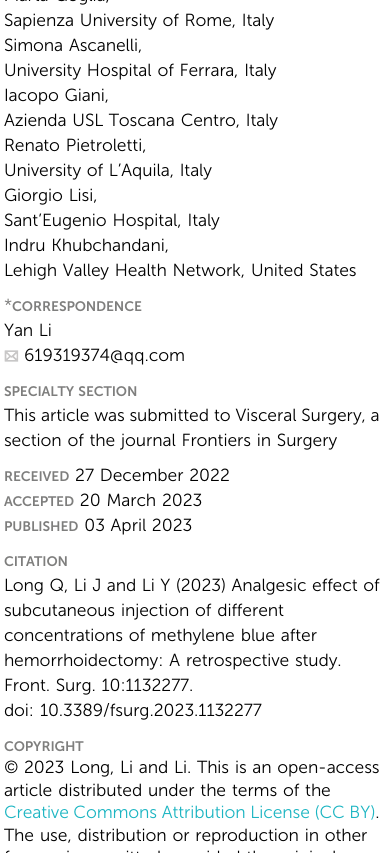
CITATION Long Q, Li J and Li Y (2023) Analgesic effect of subcutaneous injection of different concentrations of methylene blue after hemorrhoidectomy: A retrospective